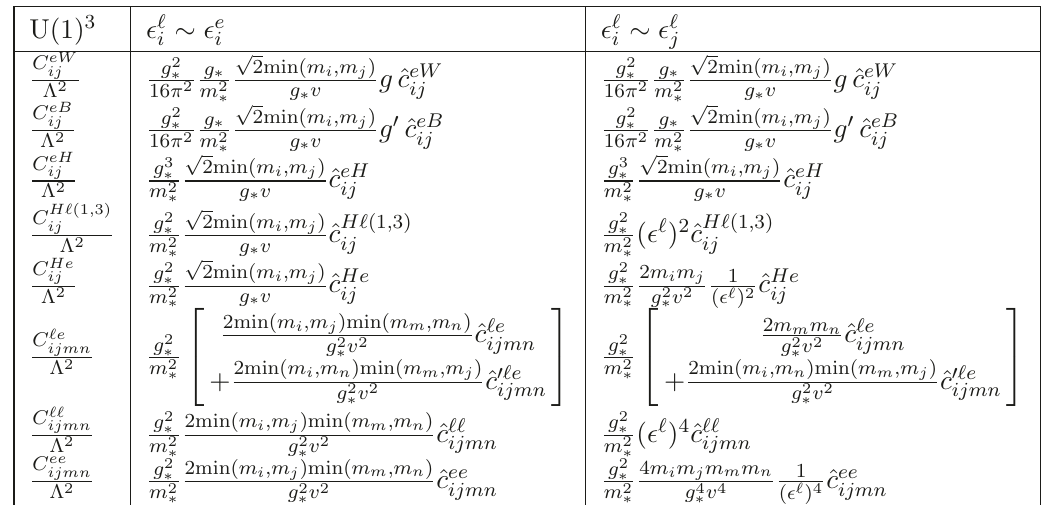
Table 7 . Wilson coefficients of the dim-6 operators in the mass basis, assuming the strong dynamics has a U(1) 3 symmetry broken by the mixings (2.1) (to be compared to the anarchic case of table 3). Here we show the result for two different assumptions on the values of ǫ ℓ,e text the predictions for C eW,eB,eH are however general and hold for any value of ǫ ψ